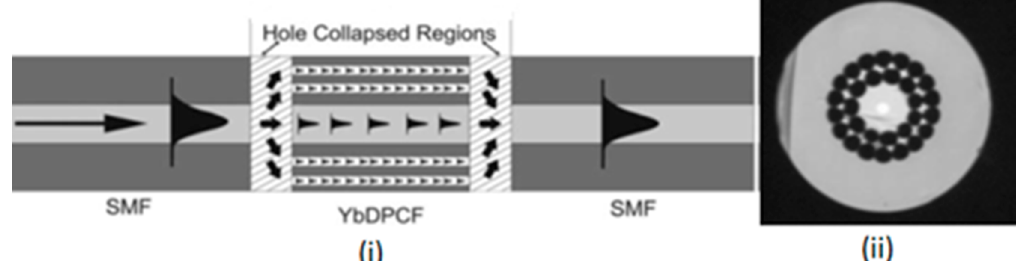
Figure 20. ( i ) Schematic diagram of the three beam path MZI used for torsion sensing and ( ii ) image of the Yb-d-DPCF cross-section (Reproduced from [85], with the permission of Wiley publishing).